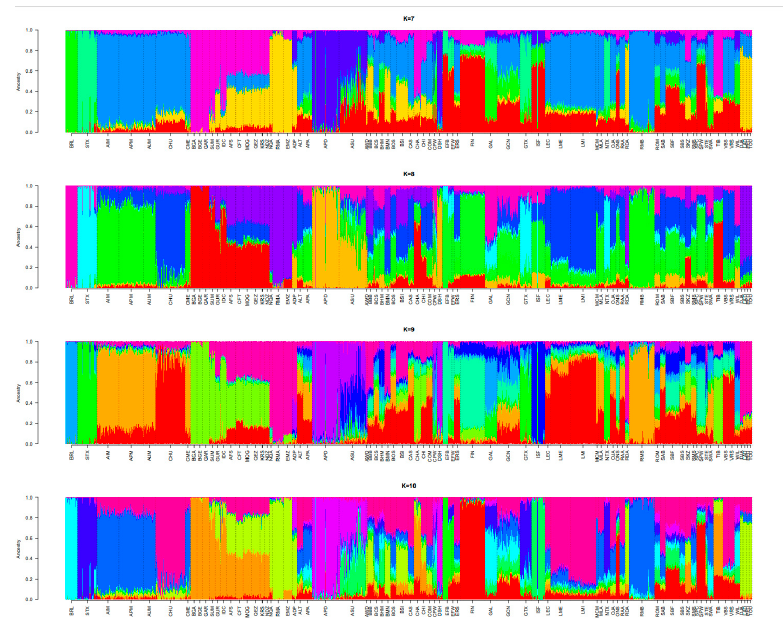
Figure 6. Unsupervised hierarchical clustering of the 2776 individuals of 77 breeds genotyped for 40,916 SNPs (WORLD-Set). Results for an inferred number of clusters k varying from 2 to 10 are shown. Each breed ID is coloured according to the breed geographic origin (i.e., in blue for Europe, in purple for America, in pink for the Caribbean, in yellow for Asia, in cyan for the Middle East, in light green for East Africa, and in dark green for South Africa).